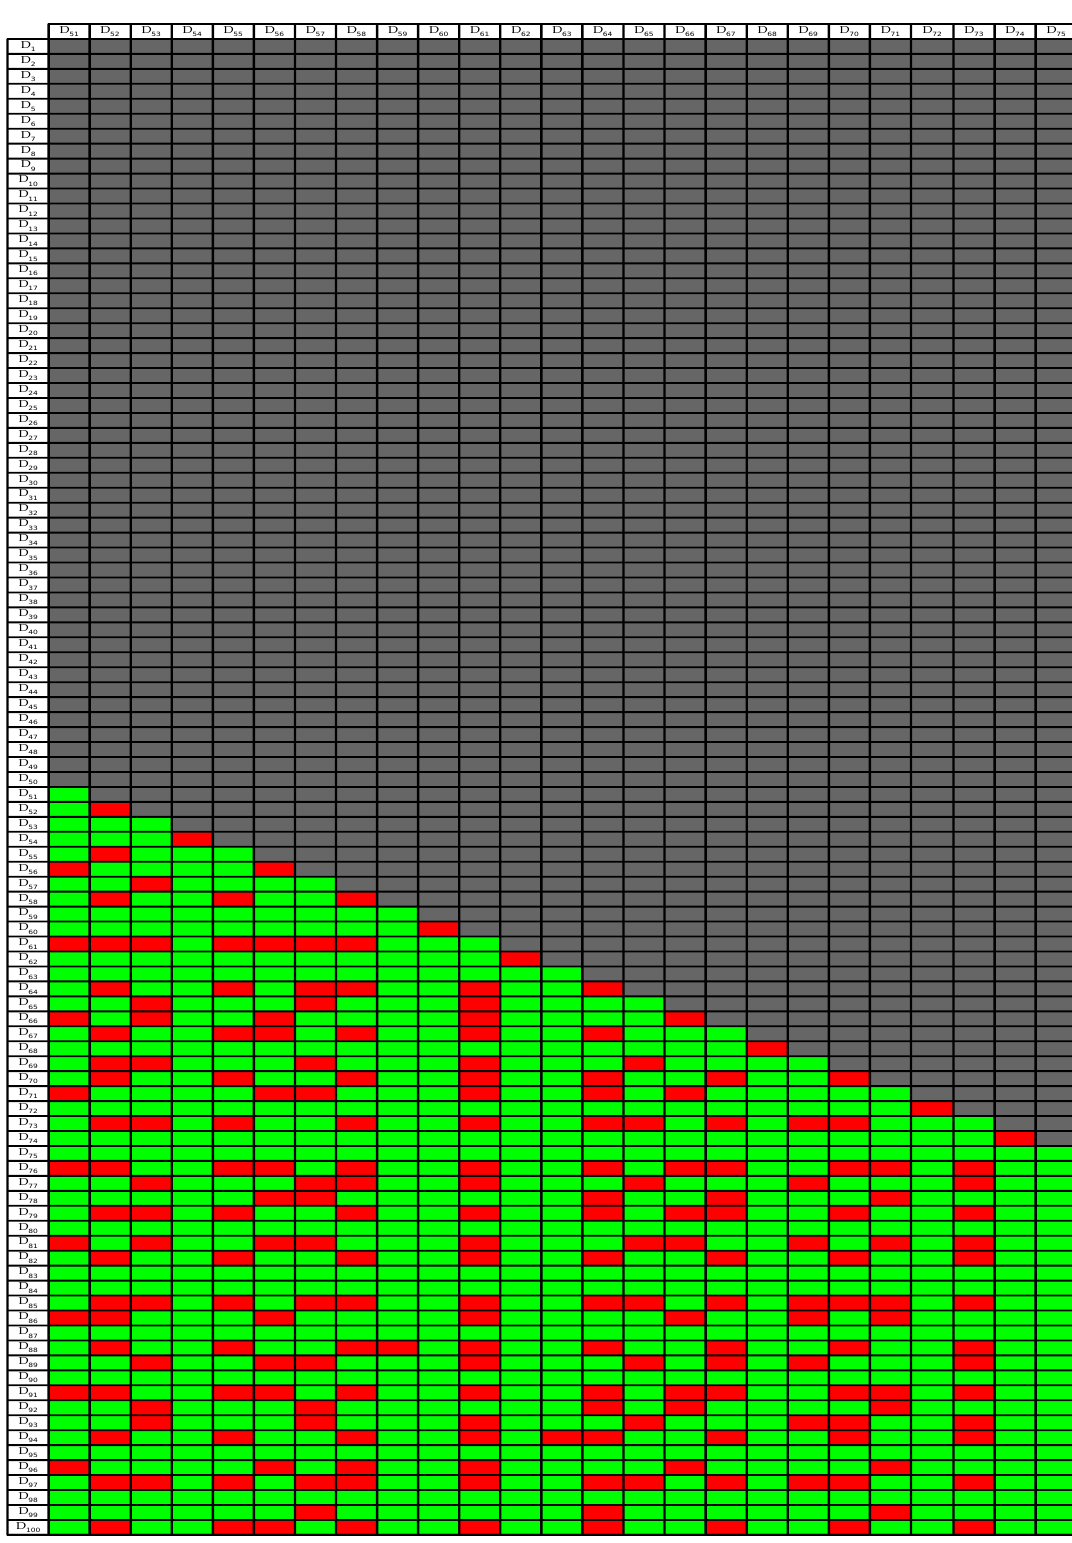
Table 12 . Analyzed theories for ( D n ; D m ) with n = 3 ; : : : 100 and m = 51 ; : : : 75.